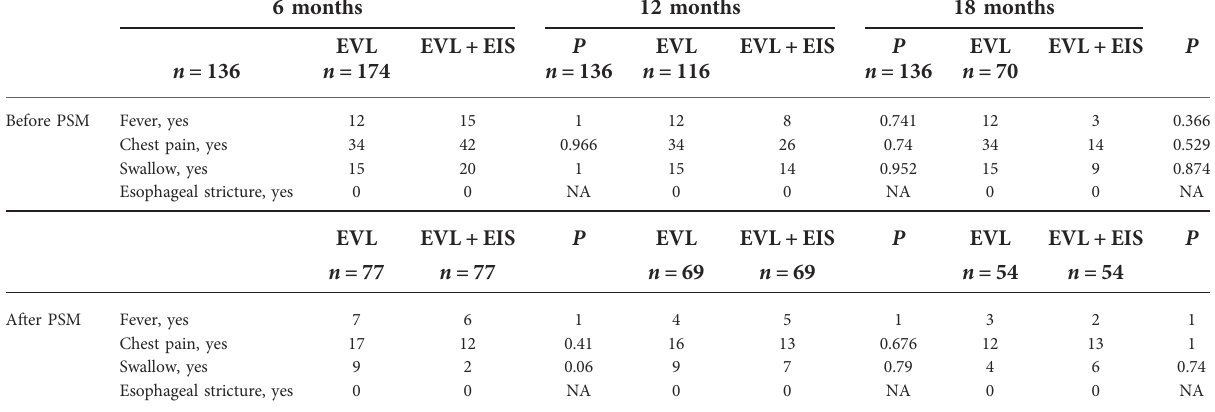
TABLE 5 Adverse